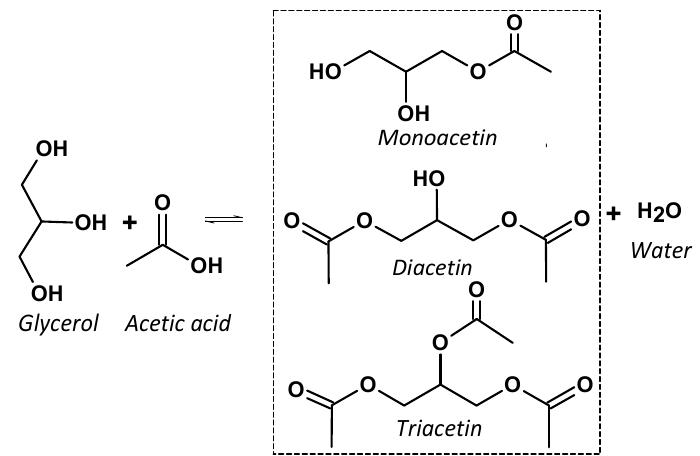
Figure 1. Scheme of the glycerol esterification reaction with acetic acid.